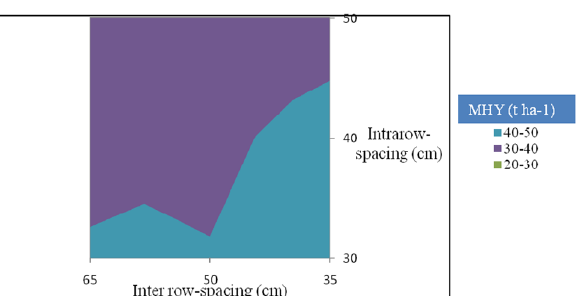
Figure 3: Response surface model of inter and intra - row spacing interaction of the marketable head yield ( MHY ) of cabbage.